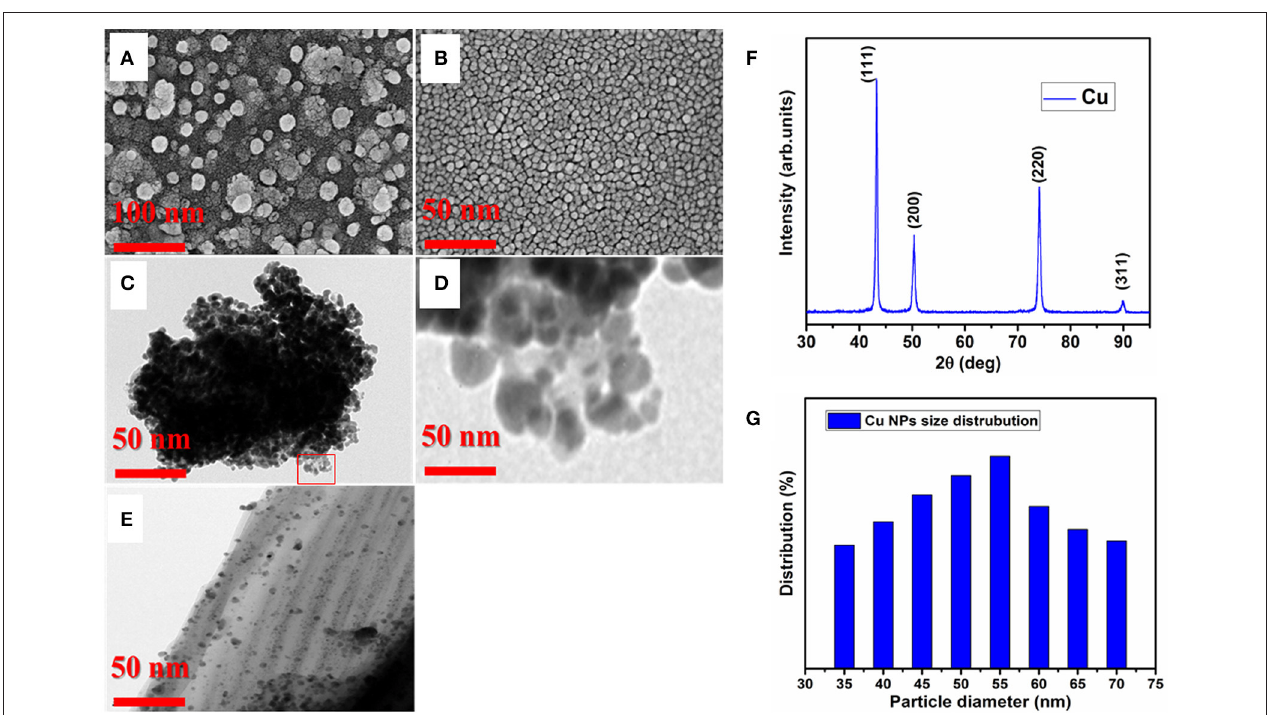
FIGURE 1 | Particle size and distribution of Cu-NPs. (A) , FESEM image of Cu-NPs before sonication (B) , FESEM image of Cu-NPs after 6h sonication (C) , TEM image of Cu-NPs before sonication (D) , Zoomed image of Cu-NPs from Panel (C) , (E) , TEM image of Cu-NPs after 6h sonication (F) , XRD pattern of Cu-NPs (G) , Average particle size distribution of